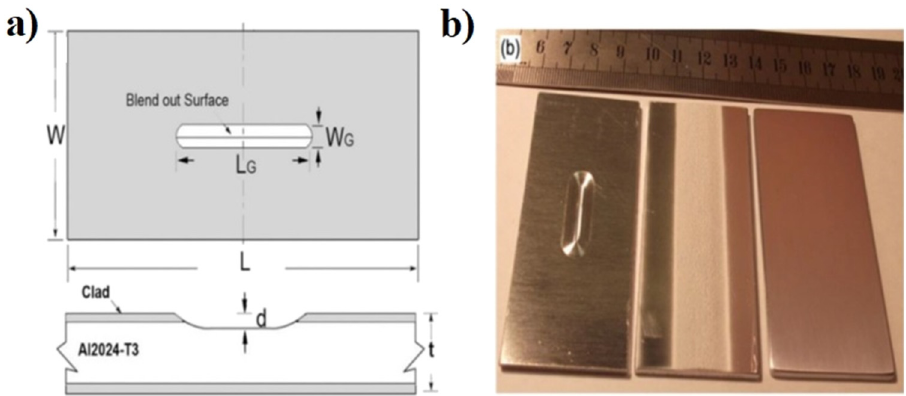
Figure 23: Restoration of Al cladding layer on Al alloy panel with self - machining damages by CSAM: ( a ) schematic representation of self - machined damage and ( b ) restoration technique [ 79 ] .